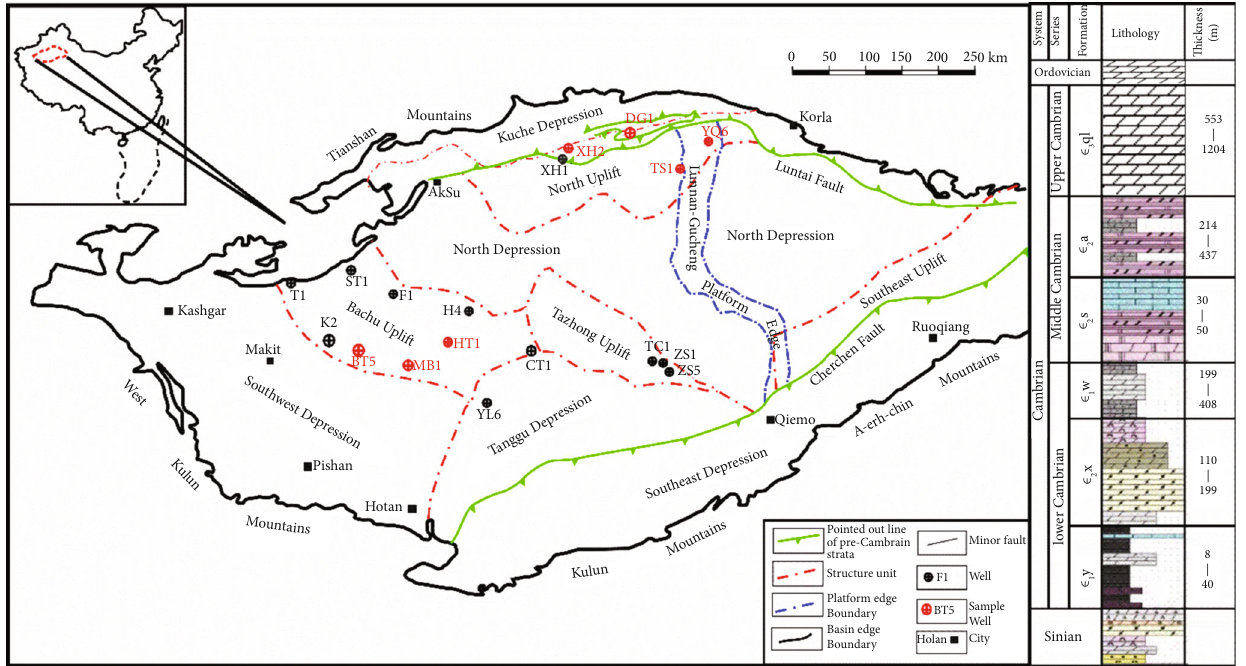
Figure 1: Basic information of the study area and distribution of the sampling